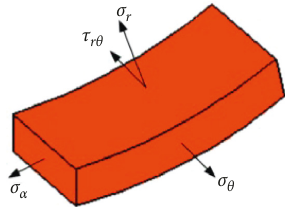
Figure 3: Main stress